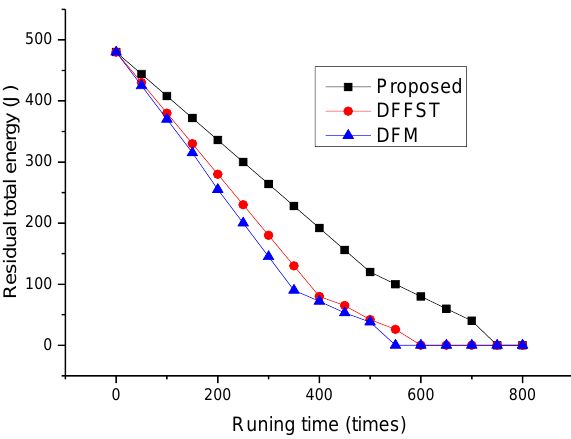
Figure 4. Relationship between the total number of network runs and the remaining total energy.